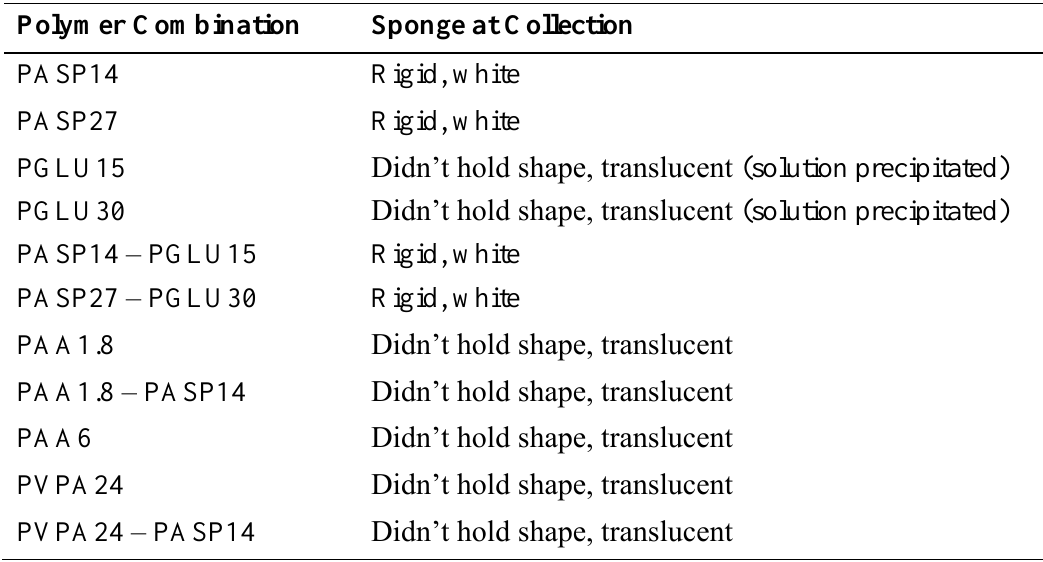
Table 2. Physical observations of samples upon